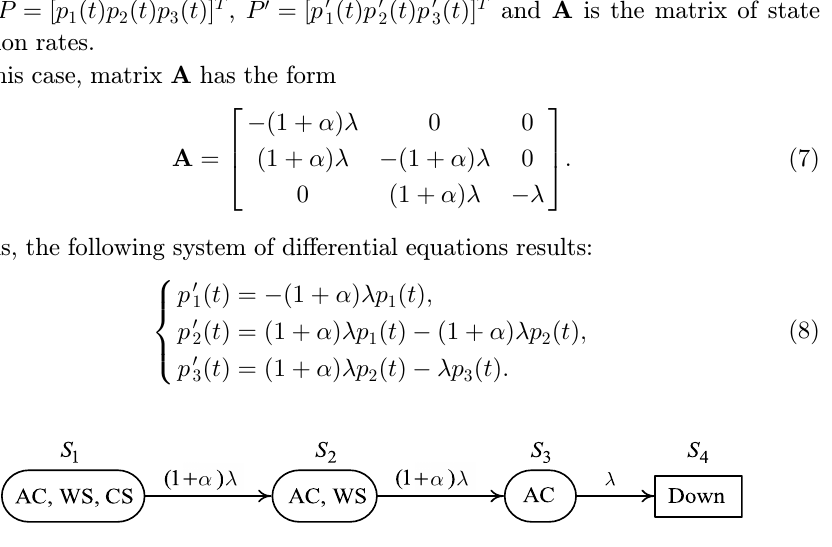
Fig. 2. Markov chain for subsystem reliability evaluation (subsystem with a WS and a cold